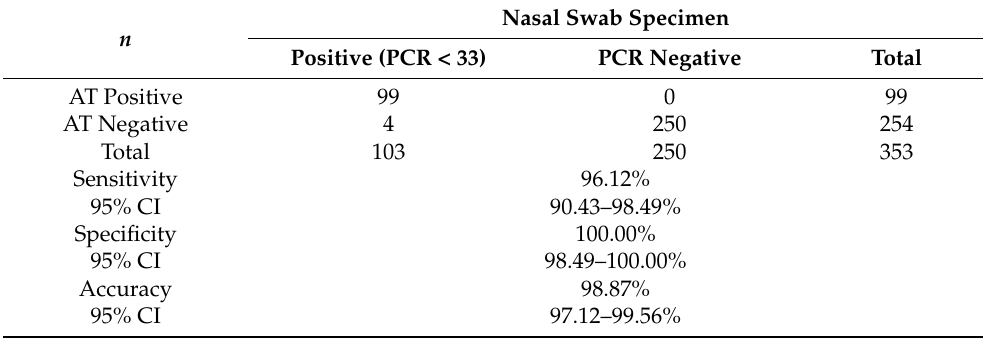
Table 5. Test results and analysis of nasal swab specimens with Ct values of PCR positivity less than 33.